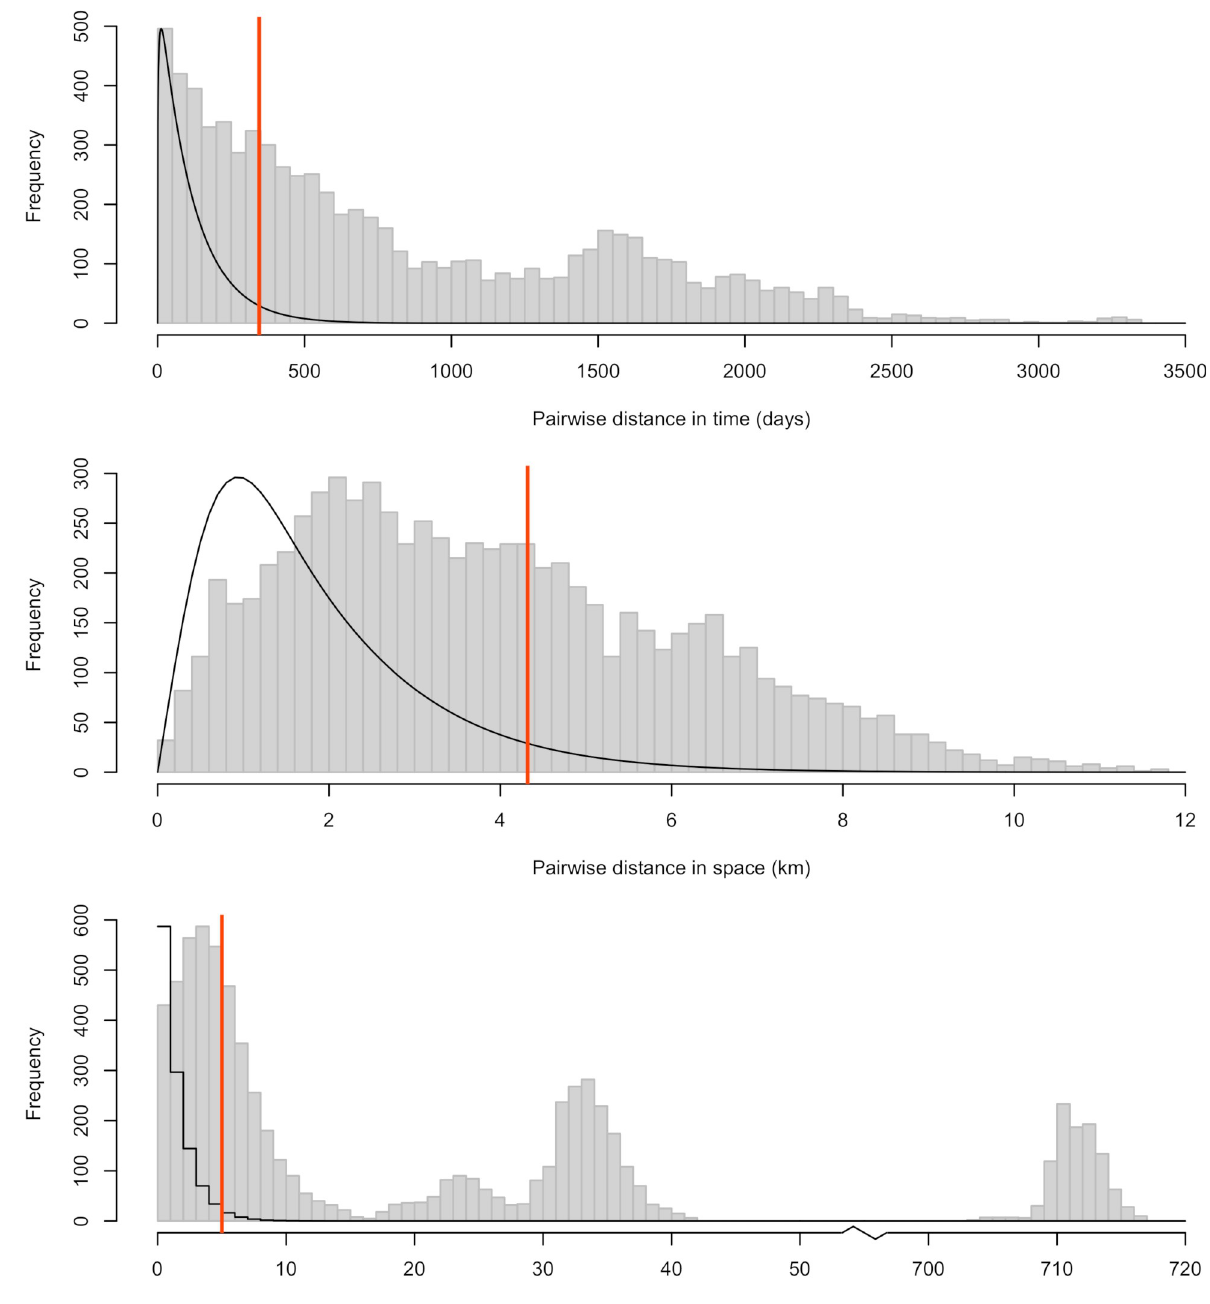
Fig 3. Distribution of pairwise temporal (top), spatial (middle) and genetic (bottom) distances for rabies in Bangui. The temporal distance is defined as the time between reporting of the cases. The spatial distance is defined as the Euclidean distance between the geographic locations of cases. The genetic distance is defined as the Hamming distance between the sequenced isolates. The grey histograms show the observed pairwise distances between any two cases reported in Bangui. The solid black lines show the input distribution of distances between a case and its closest observed ancestor, given an assumed reporting rate of 20% (see S1 Text for sensitivity analyses to this assumption). Distributions have been rescaled to fit on the same graph as the histograms. The red vertical lines show the cutoffs corresponding to the 95% quantiles of these distributions. For a given data stream and a given choice of cutoff, pairs of cases with observed distance above the cutoff are considered not connected, and the corresponding graph edges are removed at the pruning step (see Fig 1).